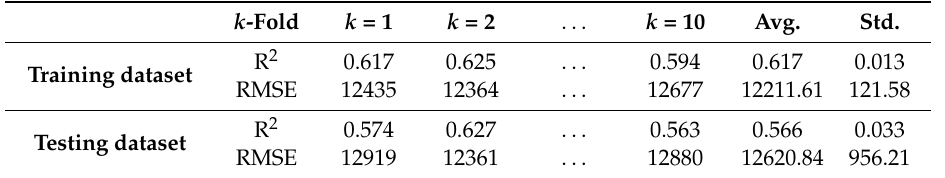
Table 9. 10-fold CV of FGLS.